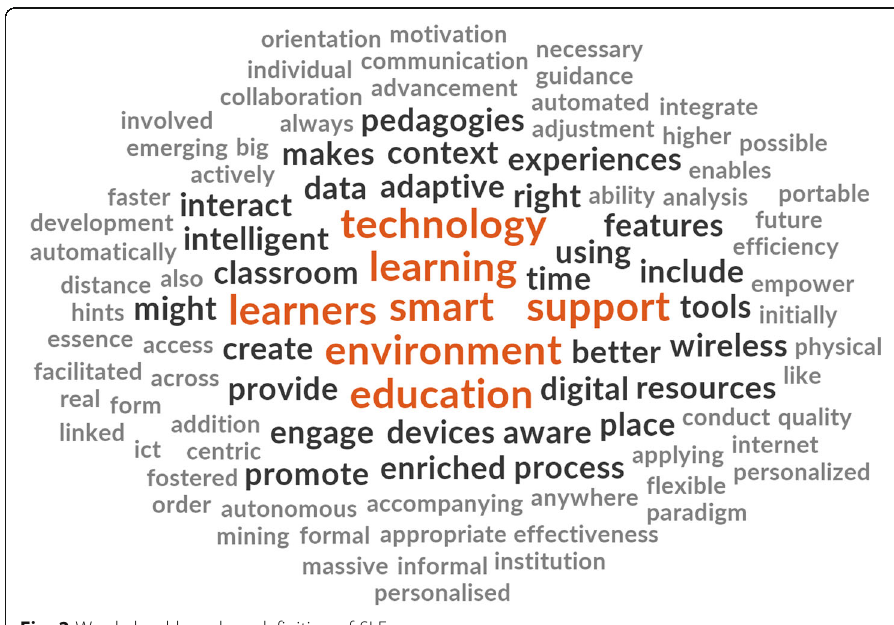
Fig. 2 Word cloud based on definition of